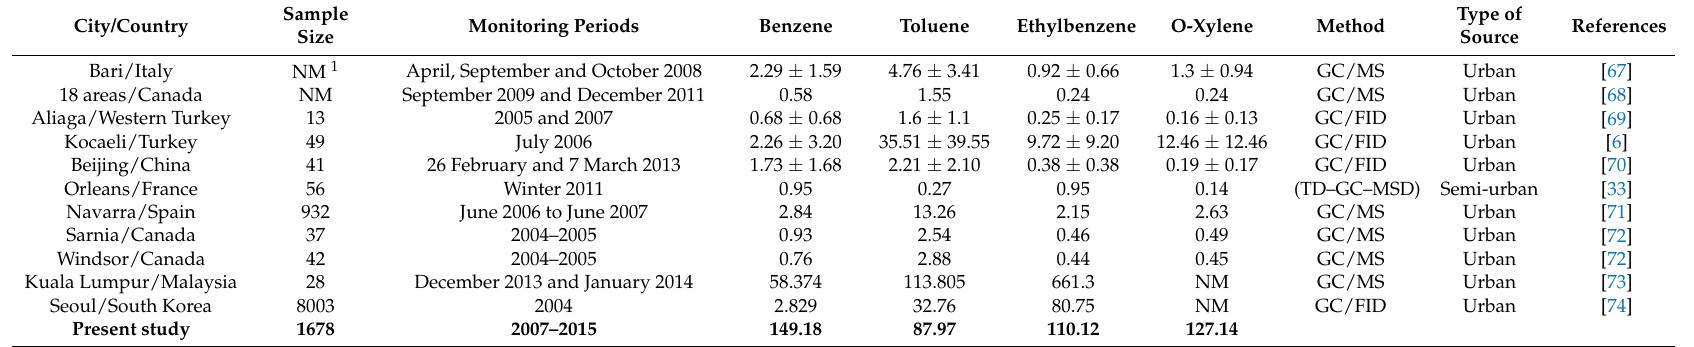
Table 3. A comparison of the concentration of BTEX in ambient air of Tehran with other regions in the world ( µ g/m 3 ). Sample City/Country Monitoring Periods Benzene Size